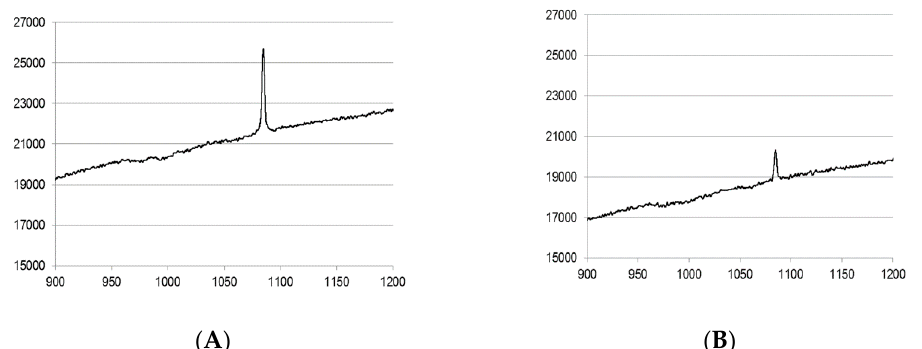
Figure 1. Raman spectrum of otolith fossil (Myctophidae spp.). The intensity of Raman band in the layer between the incremental lines ( A ) was more conspicuous than that of the incremental lines ( B ). Vertical axis: Raman intensity, horizontal axis: Raman shift (cm − 1 ).